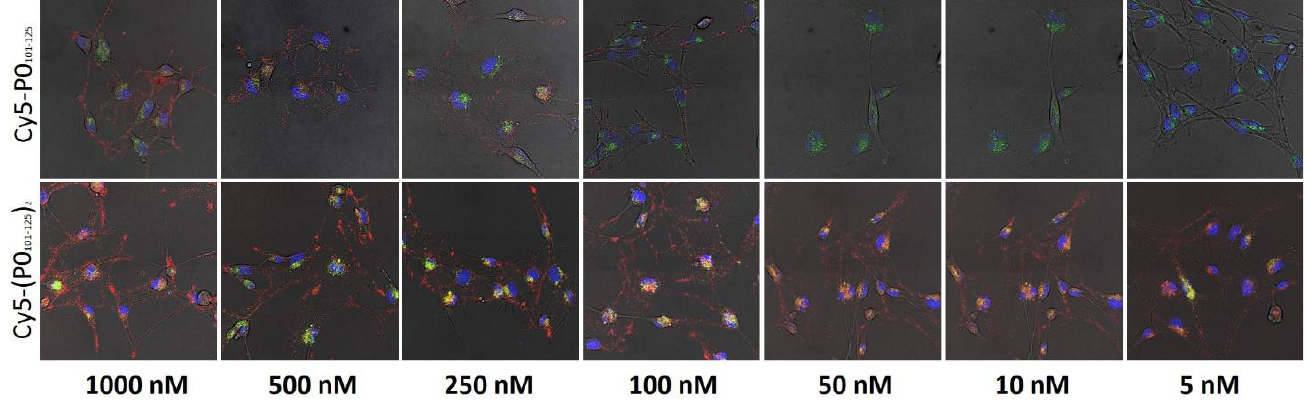
Figure 4. In vitro comparison of Cy5-P0 101–125 and Cy5-(P0 101–125 ) 2 . Fluorescence confocal imaging of P0-expressing RT4-D12 Schwannoma cells after incubation with different concentrations of either Cy5-P0 101–125 or Cy5-(P0 101–125 ) 2 (5–1000 nM). P0 tracer in red, lysosomes in green, and nucleus in blue.